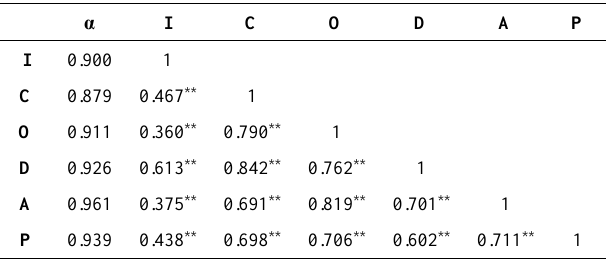
Table 7. Correlation matrix for the public sector